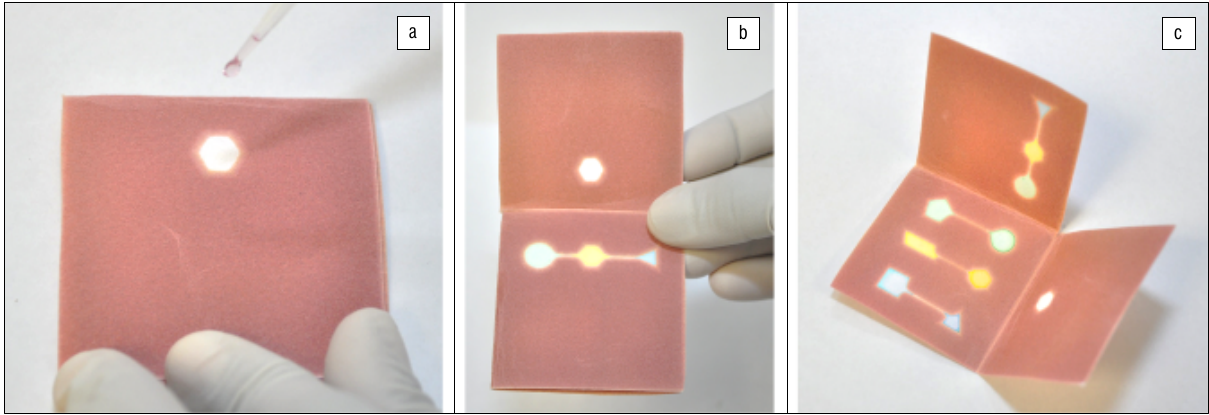
A demonstration of the reaction following the flow of the cabbage dye in distilled water on the paper-based microfluidic platform: (a) the solution is pipetted into the sample introduction shape; (b) layer C of the device is opened to show that the dye flows into the intermediate shapes on layer B, resulting in staining of the intermediate shapes; (c) after opening all the layers, one observes the effect of the multiplexing reaction in which the dye stains Milk of Magnesia green, alkaline solution yellow and ammonia blue in the test result